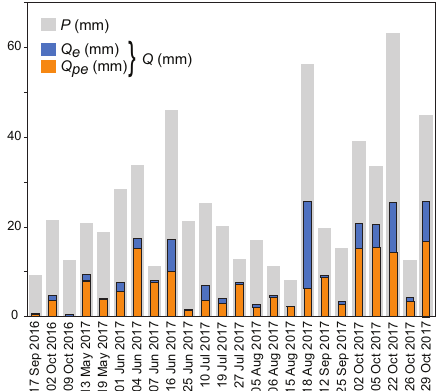
Figure 5. Volumes of precipitation ( P , grey), compared to event water ( Q e , blue) and pre-event water ( Q pe , orange) in discharge across 24 storm events. Total discharge ( Q ) is the sum of event and pre-event water; relative standard errors for Q e were between 1% and 12%, and they were between 0.1% and 13% for Q pe (Table 2). For most of the storms, pre-event water comprised the major frac- tion of streamflow. Event water dominated streamflow only during two storms (10 July and 18 August